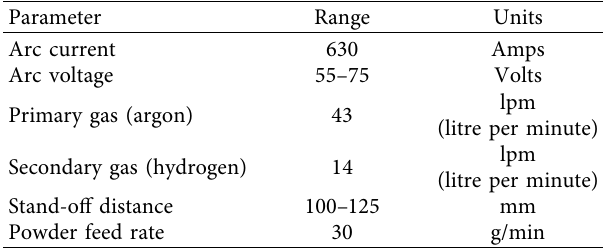
Table 2: Process parameters used for deposition of coatings using APS.